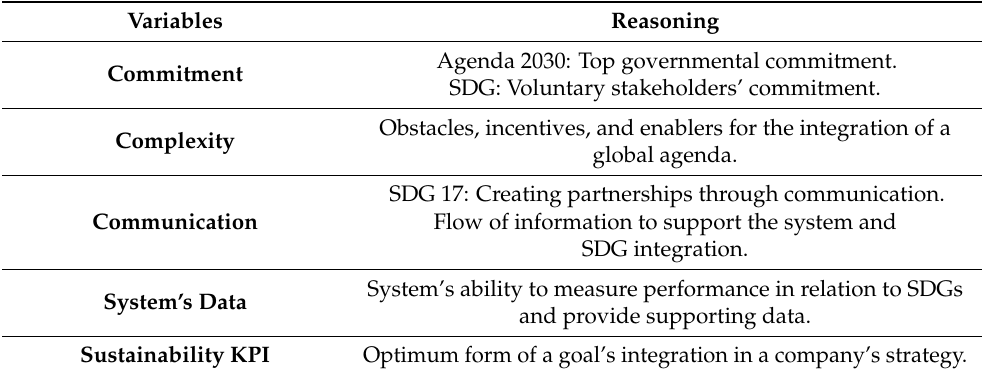
Table 3. Summary of the conceptual variables as elaborated by the